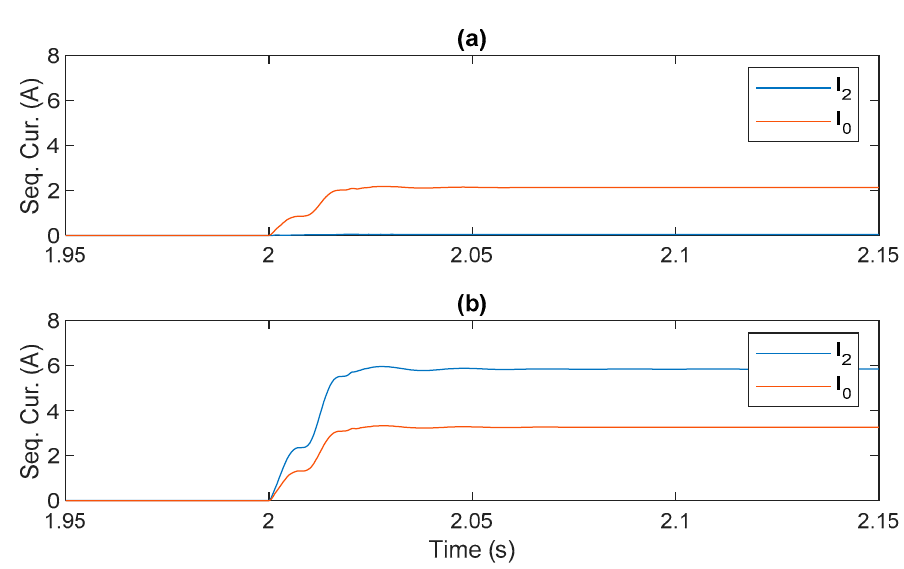
Figure 6. Zero and negative sequence currents at ( a ) healthy feeder J06; ( b ) faulted feeder J07.